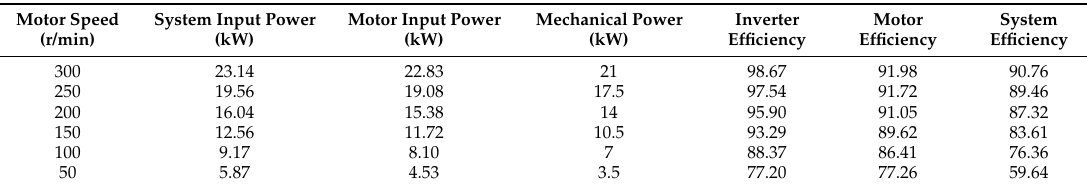
Table 8. Experimental results of the SiC-MOSFETs-based PMSM drive system at rated torque in the MTPA control.